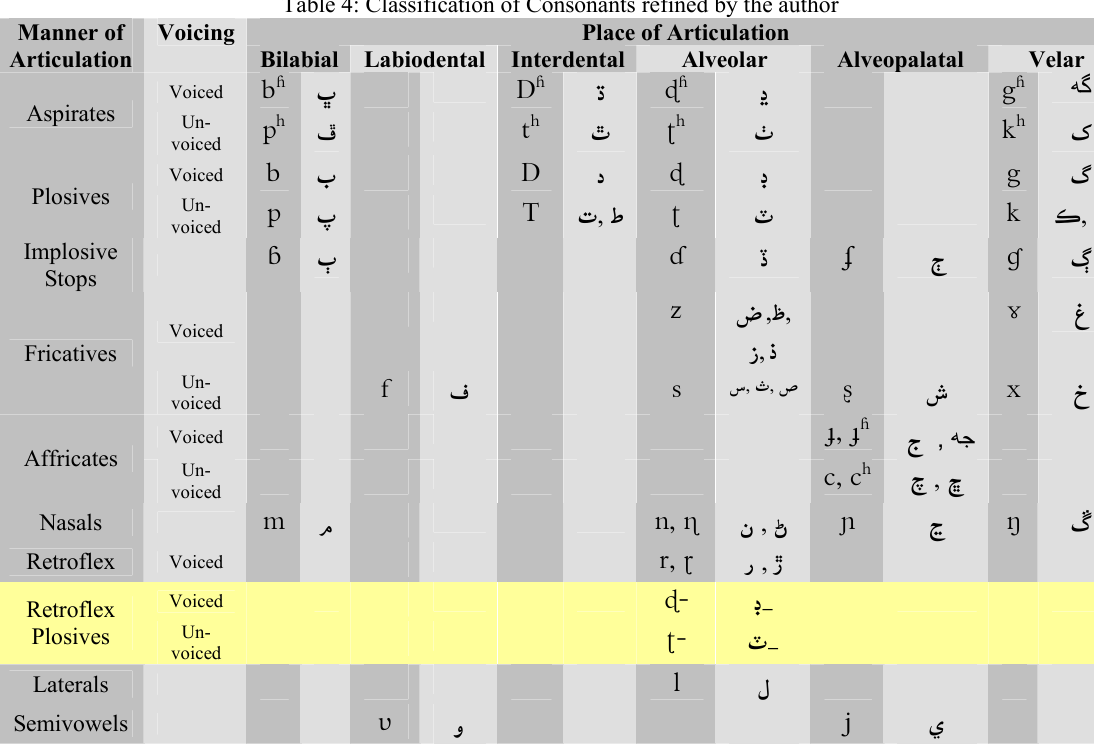
Table 4: Classification of Consonants refined by the author